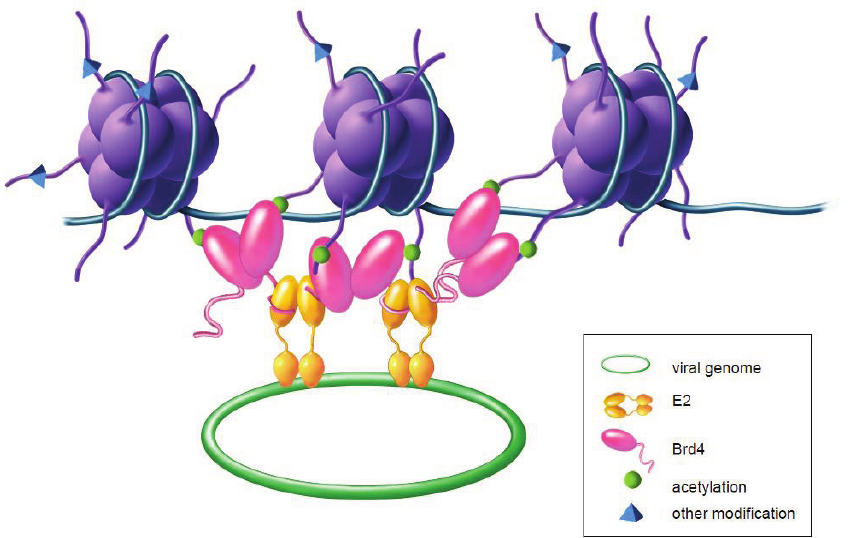
Figure 4. Model of E2-mediated tethering of the viral genome to host chromatin. The Brd4 protein interacts with acetylated lysine residues on histone tails protruding from the host nucleosomes (shown in purple). The papillomavirus E2 protein interacts with the C-terminal region of Brd4 through the E2 transactivation domain. The